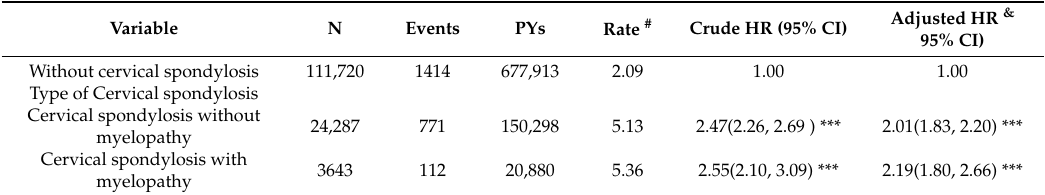
Table 4. Migraine incidences and HRs among individuals with various types of CS and those without